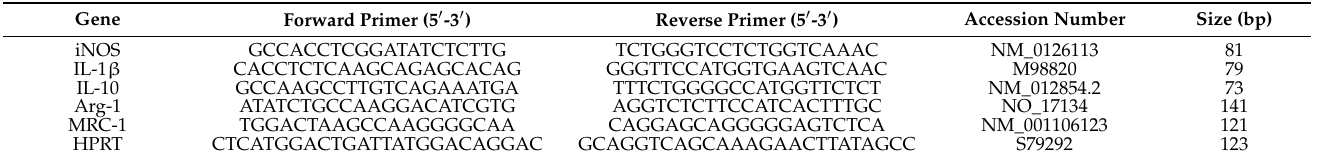
Table 1. Detailed sequences of the primers used in the Q-PCR